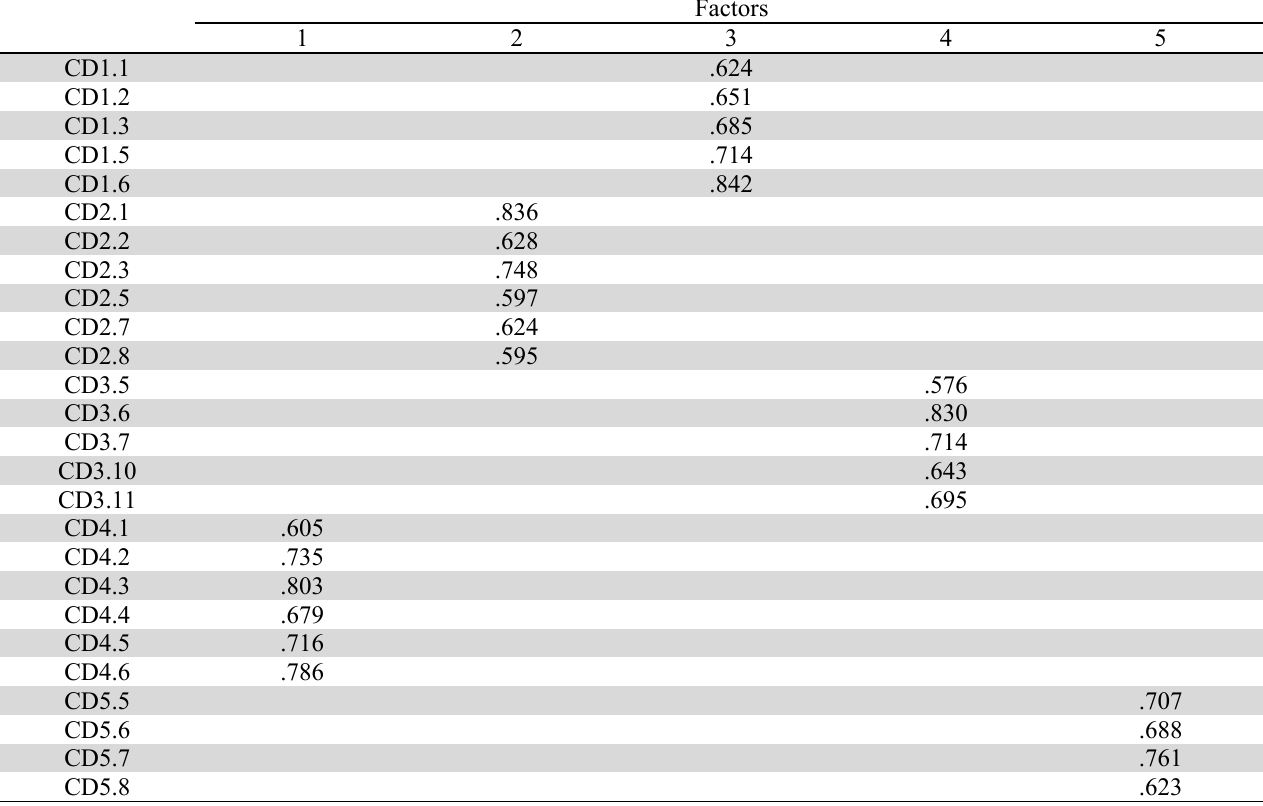
Rotation Component matrix for dependent factors (11 th time)